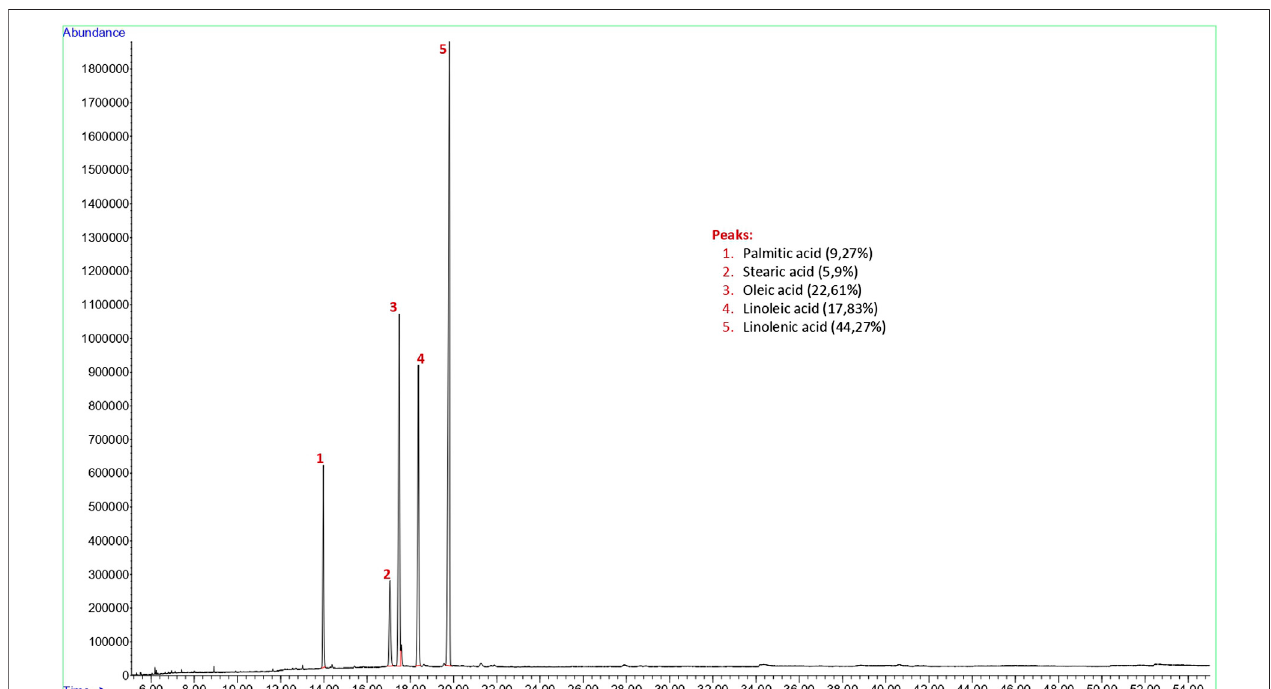
FIGURE 2 | GC-FID chromatogram of hexane extract of fl ax ( Linum usitatissimum ) seed.